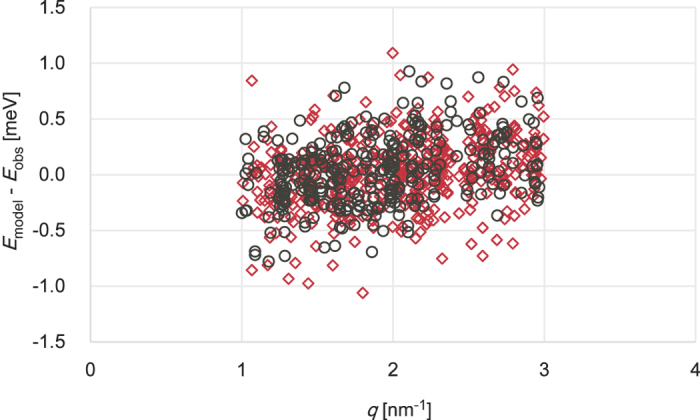
Residuals of the fitting (ΔE = Emodel − Eobs).Red diamonds and black circles are for Mg-Bdg and (Fe,Al)-Bdg, respectively.